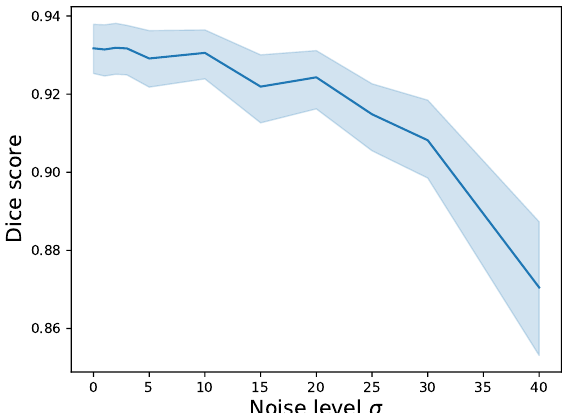
Figure 7. Dice score (mean and 95% confidence interval) as a value of the Gaussian noise level σ added to extreme points when simulating user interaction. Here, we evaluate the MO-Liver model on the CT-ORG data ( N = 139) unseen during training and